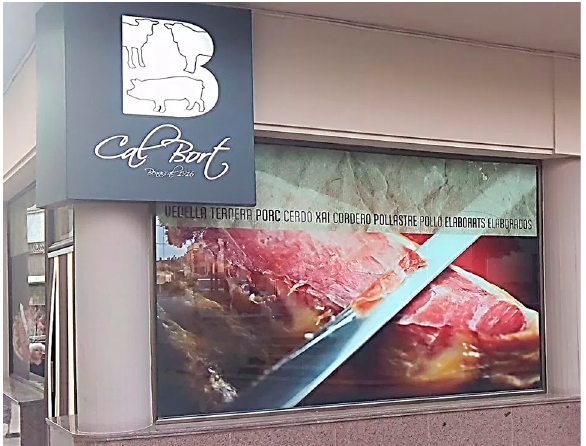
Figure 27. Benasal: Bilingual sign on a butchery.